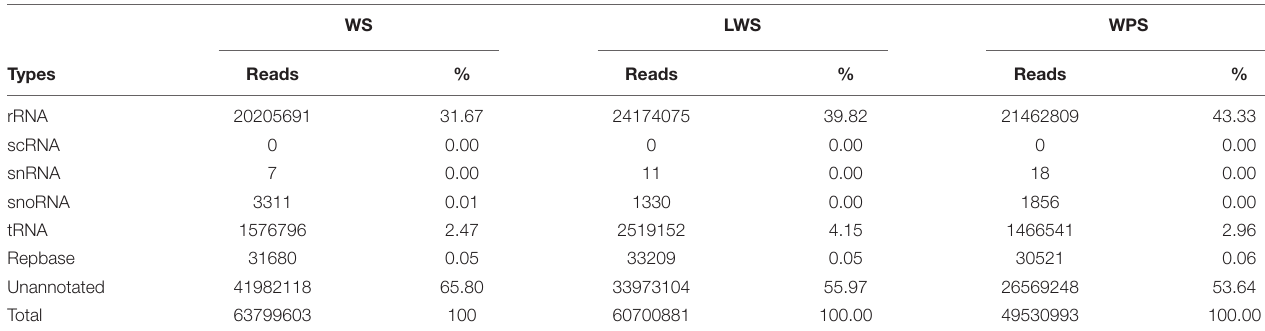
TABLE 1 | Distribution of clean reads for different RNA categories in the libraries.